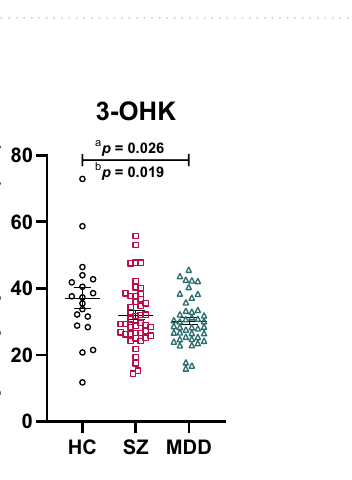
Table 2. Group differences in tryptophan and its catabolites between healthy controls (HC), patients with schizophrenia (SZ) or major depressive disorder (MDD). Statistics: 1 One-way analysis of variance, 2 Kruskal- Wallis test, Post-hoc (Tukey’s test for post-hoc comparisons of ANOVAs and Dunn’s test for post-hoc comparison of Kruskal–Wallis tests): a HC vs. SZ, b HC vs. MDD, c SZ vs. MDD. 3 log10-transformation achieved normal distribution in HC, 4 log10-transformation achieved normal distribution in patients with SZ. 5 log10- transformation achieved normal distribution in patients with MDD. 6 General linear model with age, sex, BMI, smoking and medication (chlorpromazine equivalents, imipramine equivalents, lorazepam medication) as covariates (post-hoc comparison: least significant difference). Data is presented as mean ± standard deviation. The level of significance was set at p < 0.05 (significant p -values are indicated in bold).